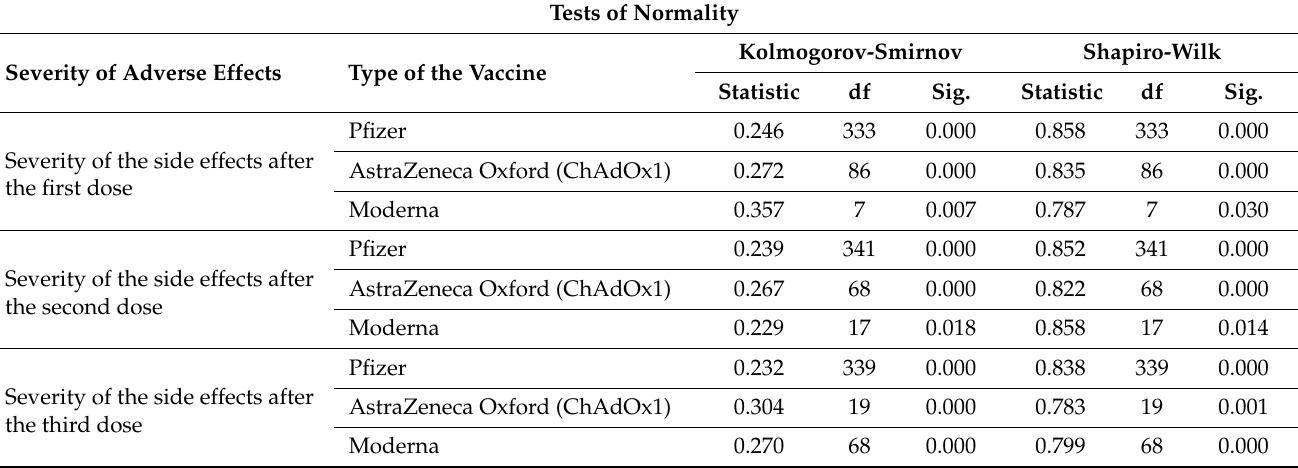
Table 5. Comparison of severity of adverse effects between Pfizer-BioNTech, Oxford-AstraZeneca and Moderna Vaccines.